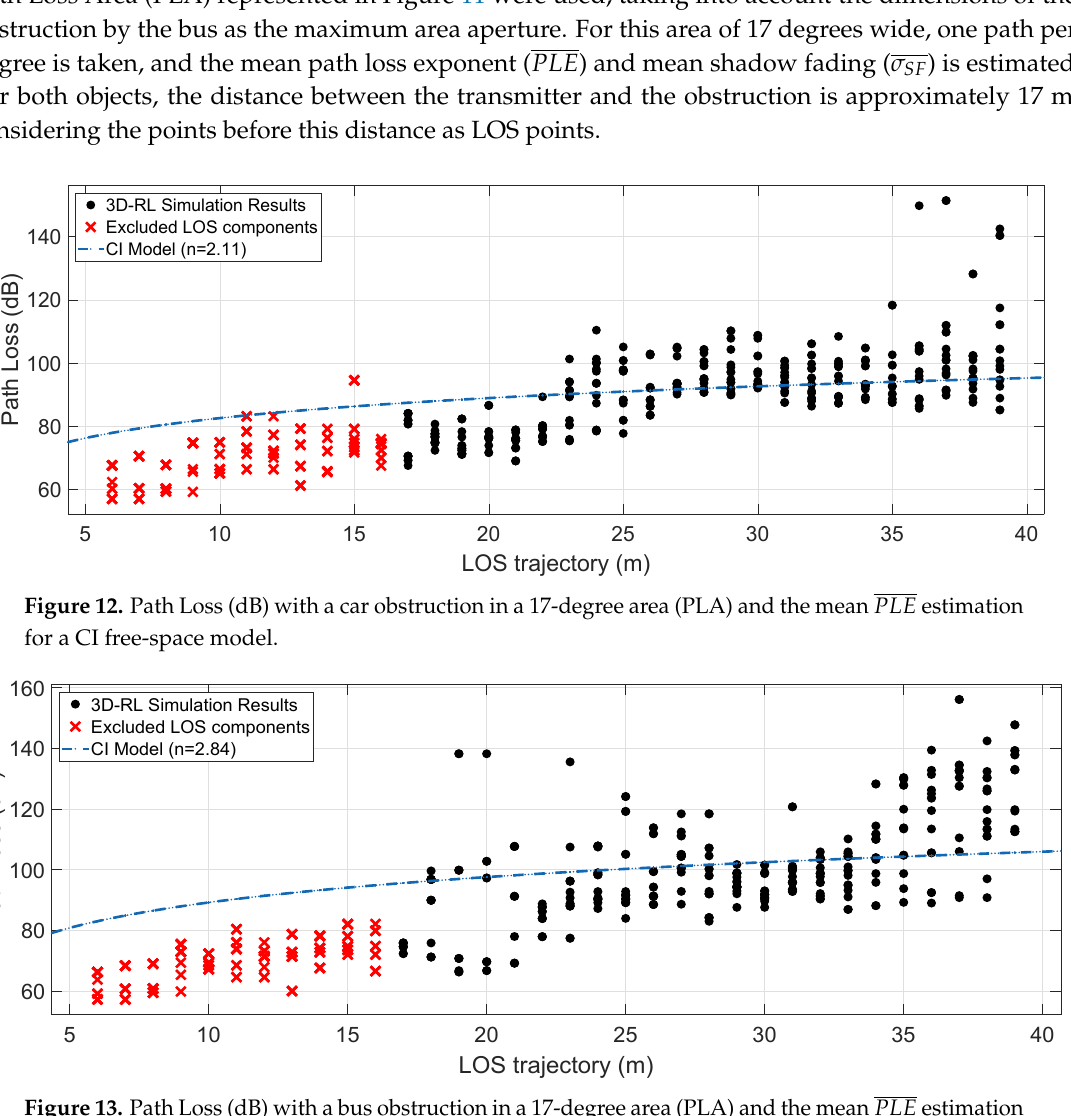
Figure 13. Path Loss (dB) with a bus obstruction in a 17-degree area (PLA) and the mean PLE estimation for a CI free-space